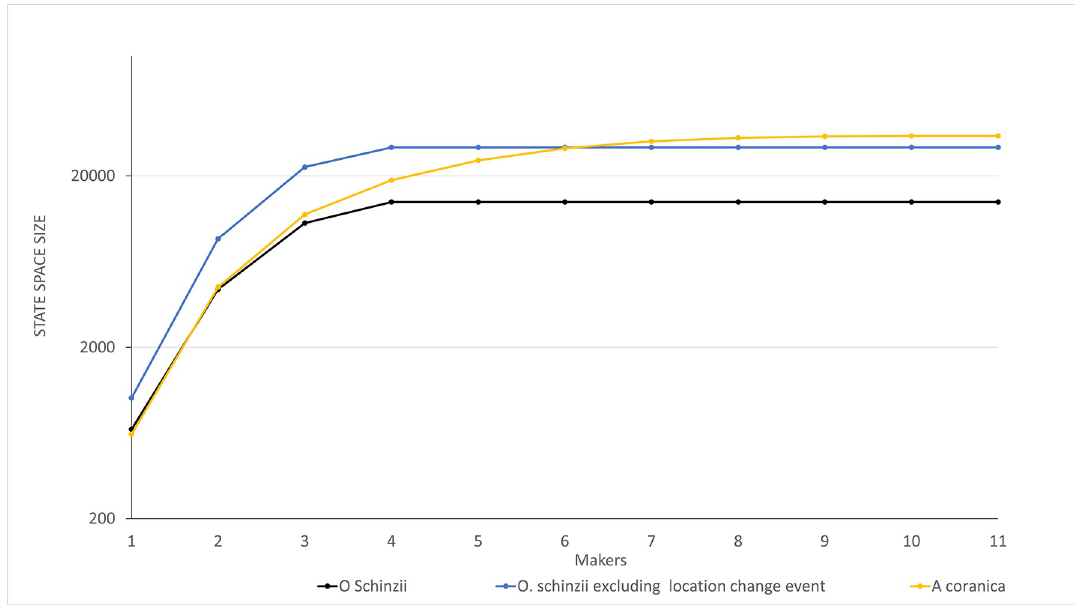
Fig 21. Comparison of the state space of the models. The lines represent the states spaces for the simulations of the A . coranica (yellow) and O . schinzii (black) models and the effect of deleting the transition ‘Back home’ associated with the location change from the O . schinzii model (blue). The state space size (vertical axis) is plotted on a log scale. The number of makers of each simulation (horizontal axis) is plotted on a linear